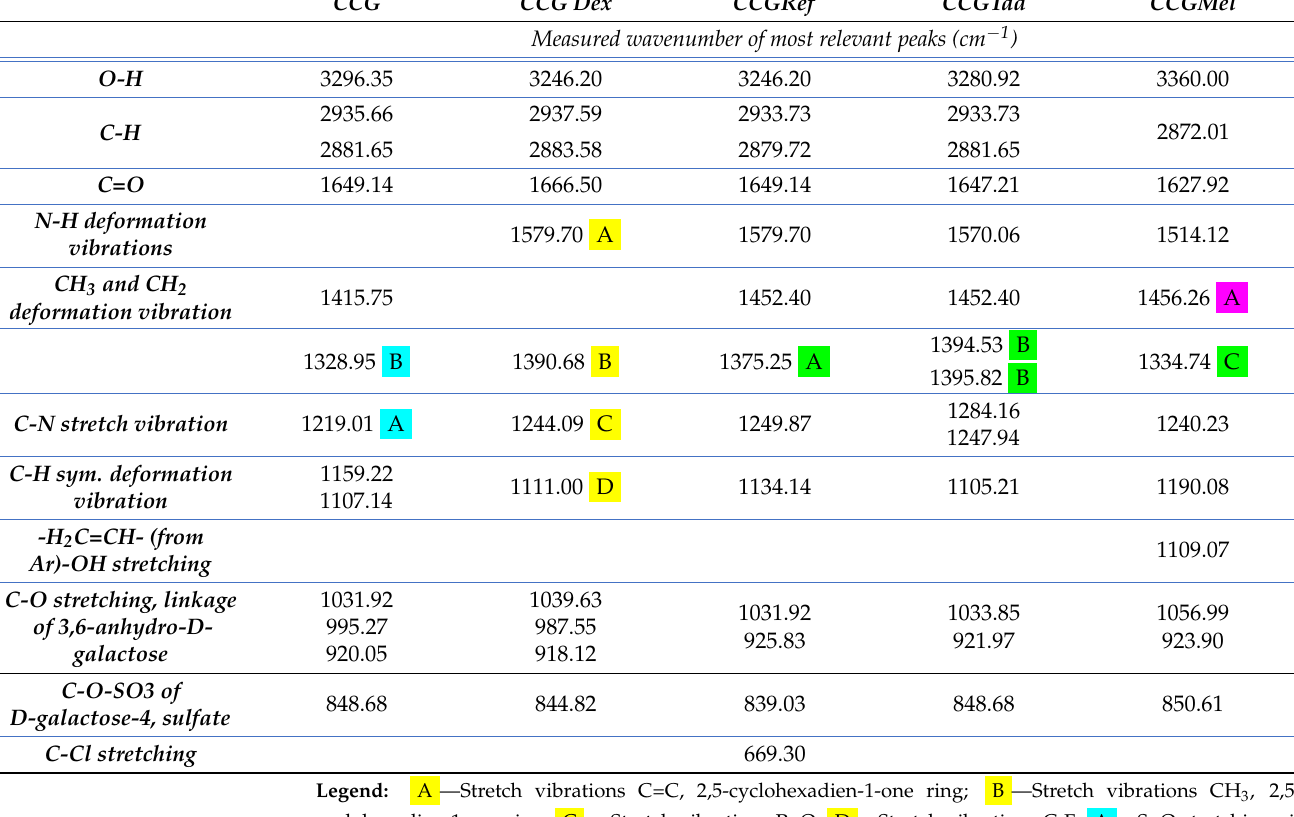
Table 3. Wavenumber values of most relevant peaks found in FT-IR spectra of type B